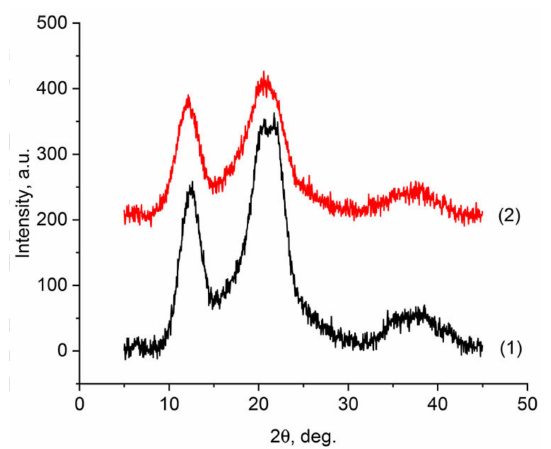
Figure 1. Diffractograms of the initial cellulose film C-1 (1) and lyocell-type film LF-1 (2). A distinctive feature of native cellulose is the presence of three characteristic peaks in the diffraction patterns in the region (~14.6 ◦ , ~16.6 ◦ , and ~22.7 ◦ ), which correspond to polymorph I [46]. As can be seen from Figure 1, the observed diffraction patterns for samples LF-1 and C-1 are similar in appearance. At the same time, the diffraction pattern of regenerated cellulose is fundamentally different from that observed for polymorph I. The main reflections in the diffraction patterns are in the reflection region 2 θ ~12.1 ◦ , 2 θ ~20.1 ◦ , and 2 θ ~21.5 ◦ , and refer to the planes (101), (101), and (002), respectively [47]. The observed structure of regenerated cellulose refers to the cellulose II polymorph [48]. An